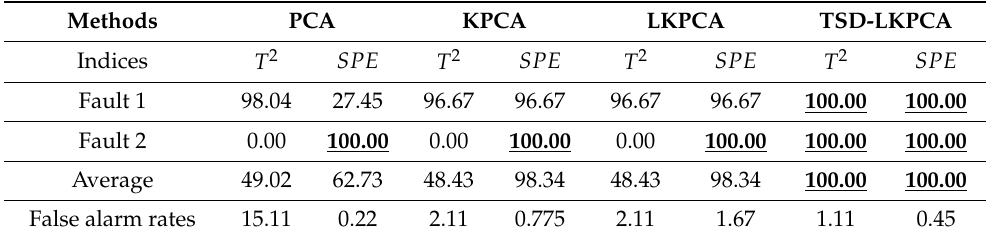
Table 3. Monitoring results (%) of PCA, KPCA, LKPCA, and